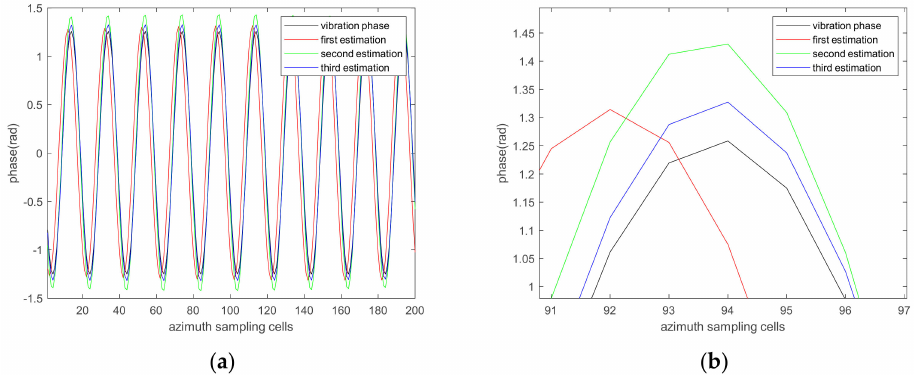
Figure 11. ( a ) Vibration phase and its estimated value under condition 2. ( b ) Partial enlargement of ( a ).